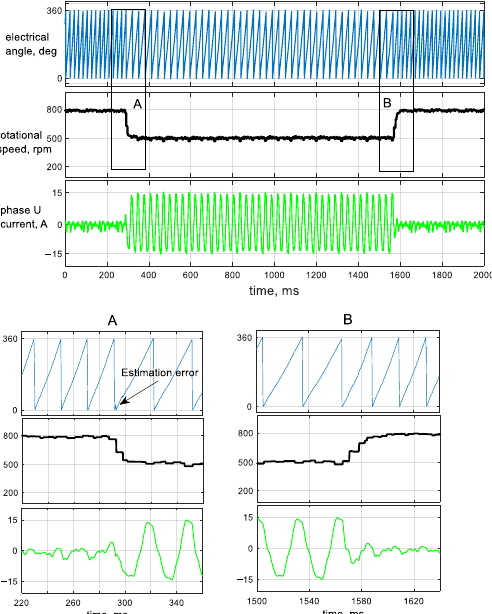
Figure 11. The course of the estimated value of the Θ M angle, the measured rotational speed and the motor phase U current, for the system operating in the open-speed loop regulation system for a load torque change of 0 – 60 – 0% of nominal torque. the results are presented in Figure 12.